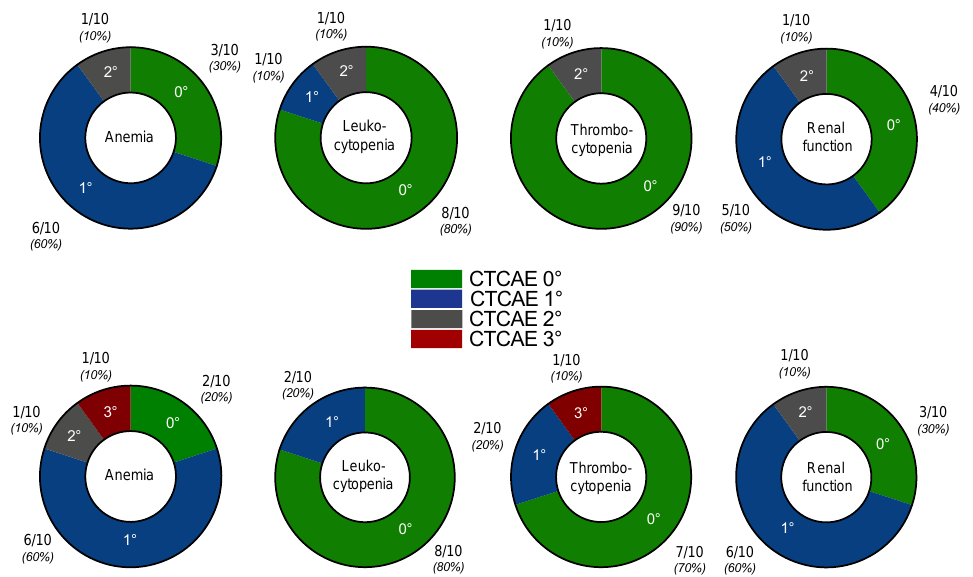
Figure 4. CTCAE grades for anemia, leukocytopenia, thrombocytopenia, and renal function at baseline, i.e., before addition of enzalutamide ( upper row ) and after two cycles of enzalutamide-augmented PSMA-RLT (lower row).